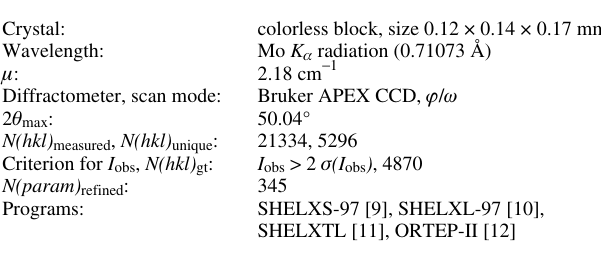
Table 1. Data collection and